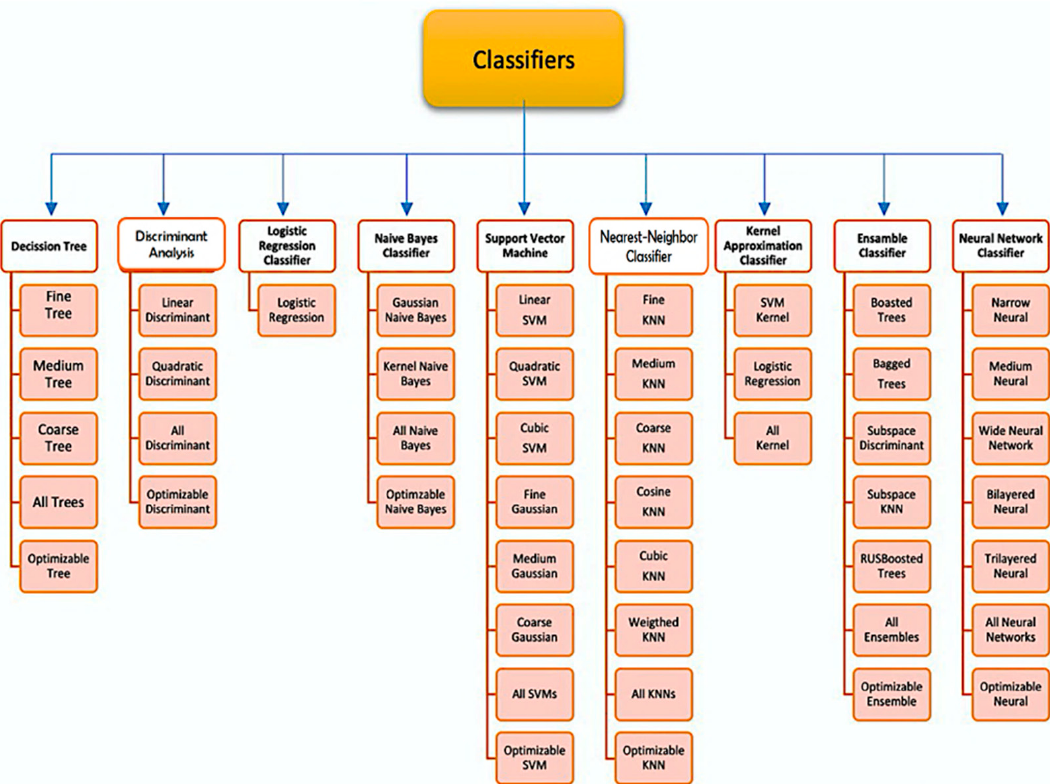
Figure 8. Classifier algorithms were tested.